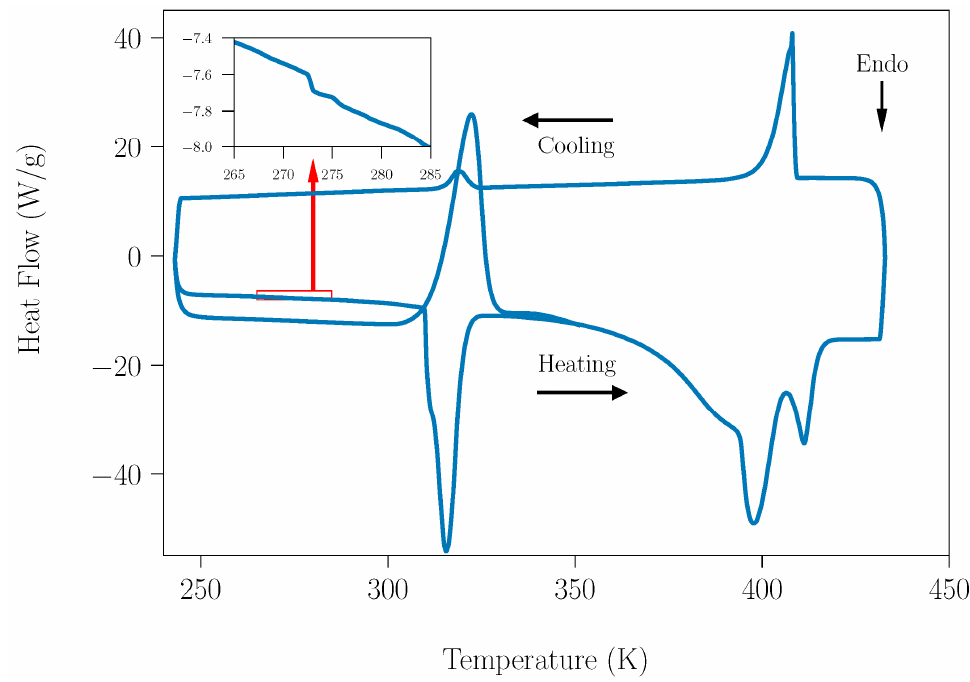
Figure 1. DSC of the S Lab (peritectic composition under laboratory humidity conditions) acquired at a 10 K · min − 1 heating rate.